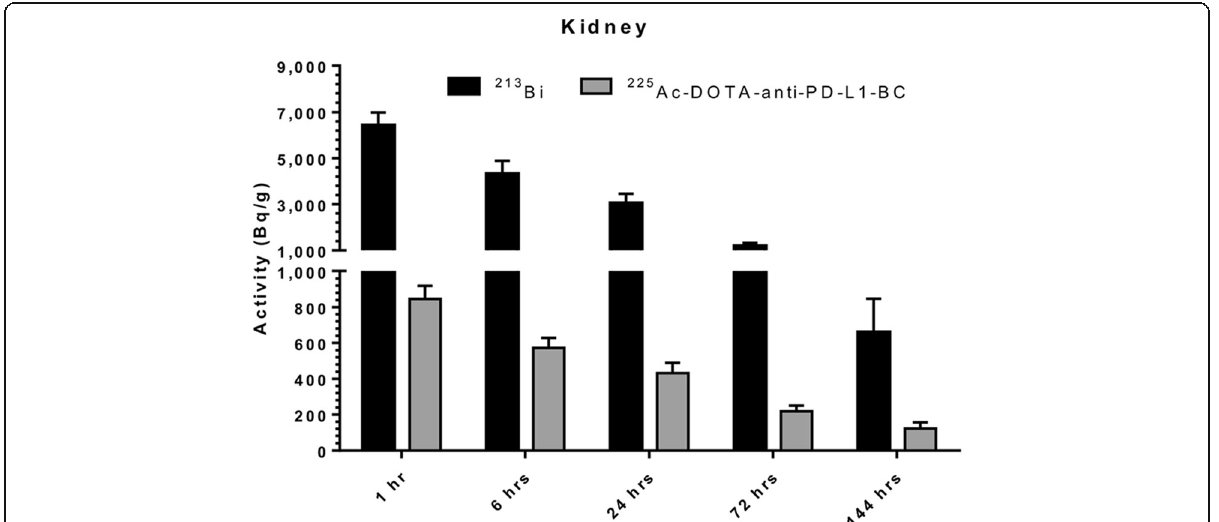
Fig. 10 Activity per unit mass (Bq/g) in kidneys for free 213 Bi ( black bar ) and 225 Ac-DOTA-anti-PD-L1-BC ( gray bar ) at 1, 6, 24, 72, and 144 h p.i.